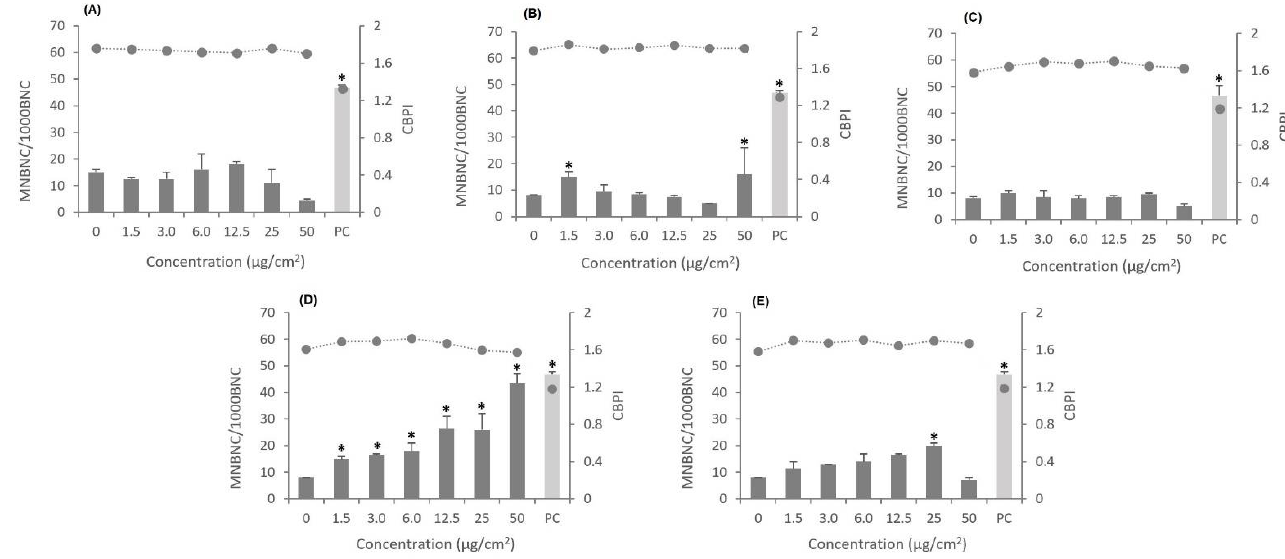
Figure 8. Intracellular reactive oxygen species (ROS) production after 1 h and 24 h exposure of A549 cells to nanocellulose and MWCNT samples under study: ( A ) 1 h exposure to CNF-TEMPO, CMF- ENZ, and CNC; ( B ) 1 h exposure to NM-401 and NM-402; ( C ) 24 h exposure to CNF-TEMPO, CMF- ENZ, and CNC; and ( D ) 24 h exposure to NM-401 and NM-402. The results are expressed as mean ± SD of three independent experiments, each carried out in triplicate. * Denotes a statistically signif- icant difference from the control ( p < 0.05).